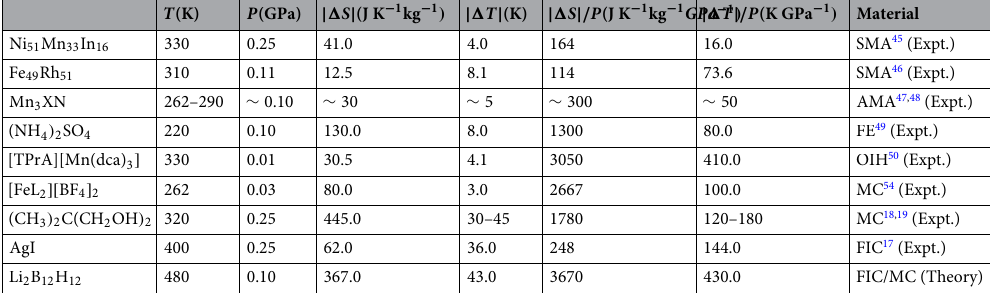
Table 1. Materials presenting giant ( | (cid:31) S | ∼ 10 J K − effects. T working temperature, P applied pressure, | (cid:31) S | isothermal entropy change, | (cid:31) T | adiabatic temperature change, | � T | / P barocaloric strength, SMA shape-memory alloy, AMA antiferromagnetic metallic alloy (X = Ga,Ni), FE ferroelectric, OIH organic–inorganic hybrid perovskite, MC molecular crystal, FIC fast- ion conductor. All references correspond to experimental works (Expt.) except for the present computational study